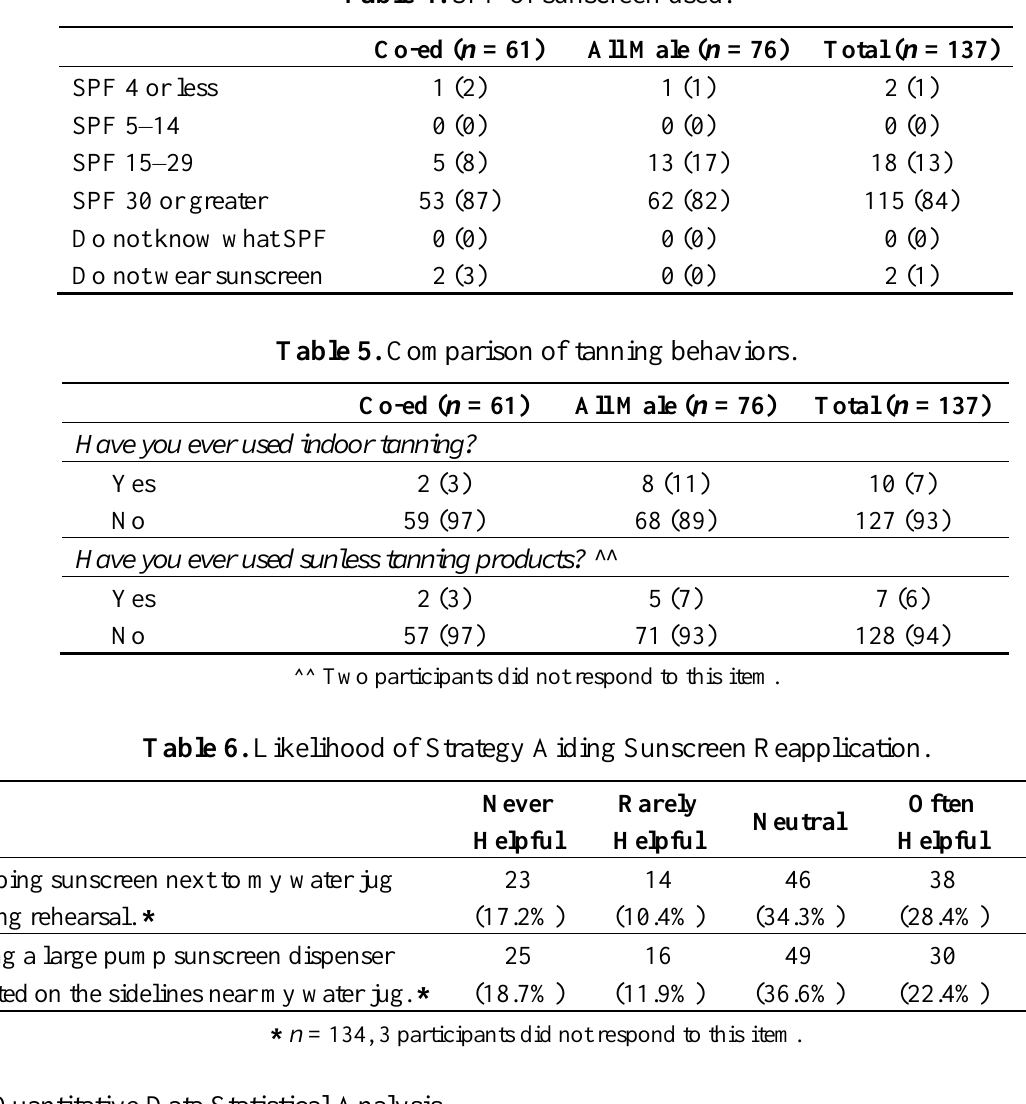
Table 4. SPF of sunscreen used.